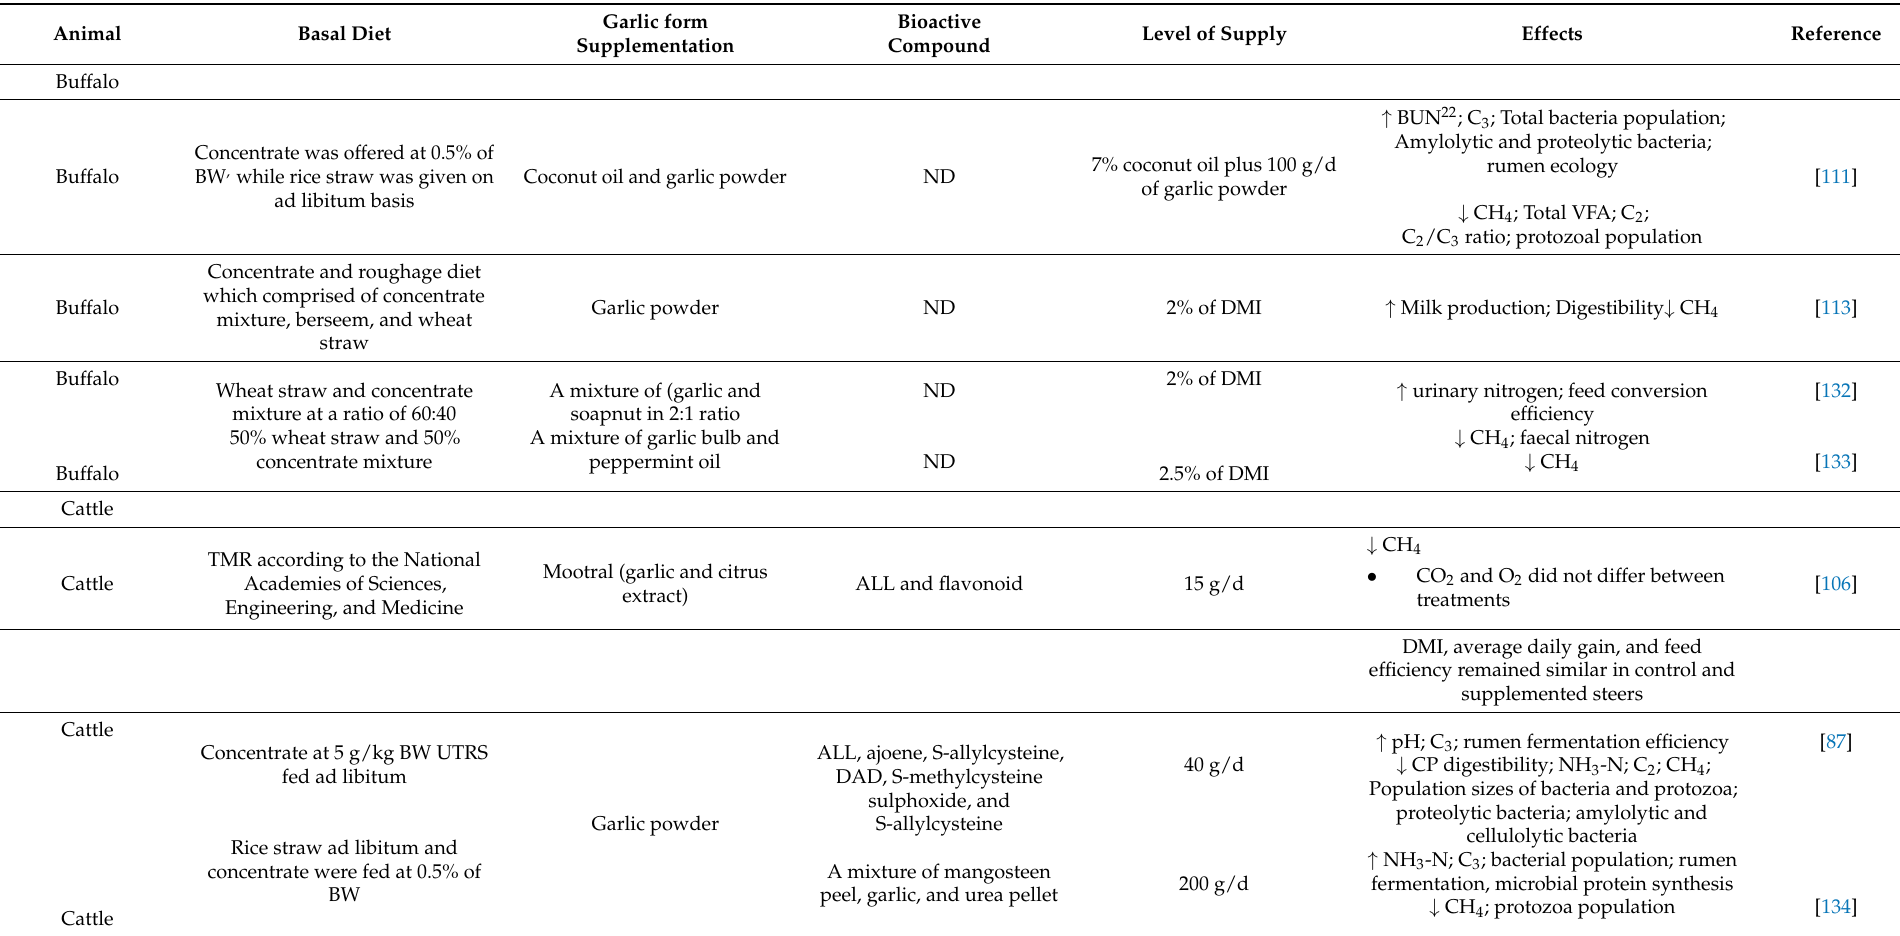
Table 3. The effect of bioactive compounds in